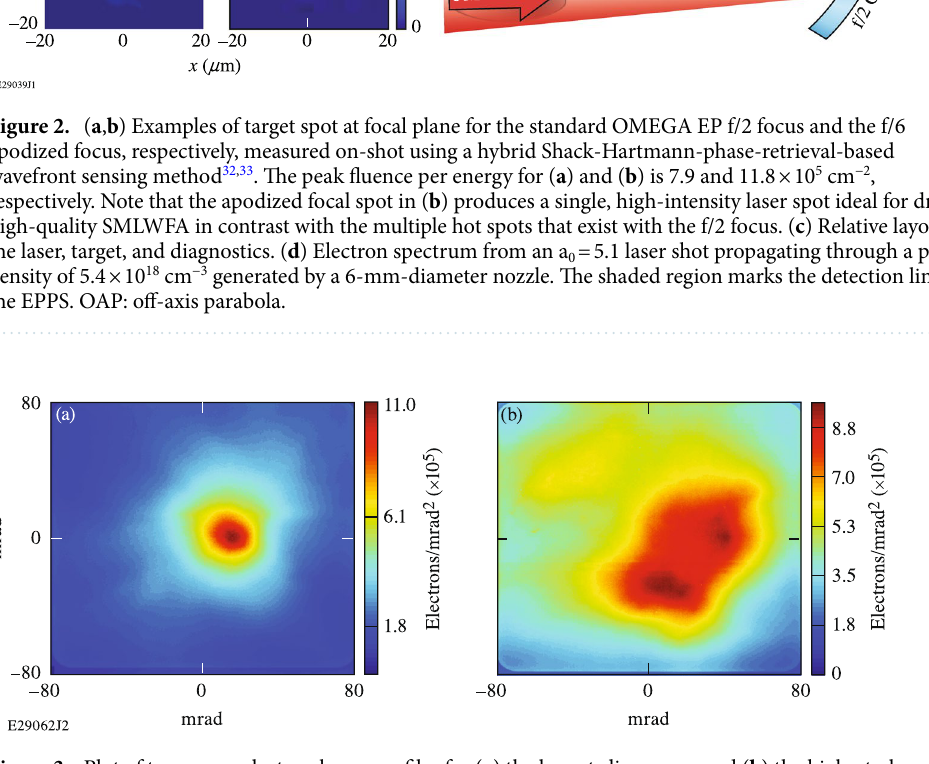
Figure 3. Plot of transverse electron beam profiles for ( a ) the lowest-divergence and ( b ) the highest-charge electron beams. Both laser shots were taken with an f/5